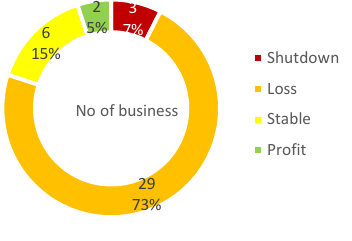
Figure 8: No of business w.r.t status